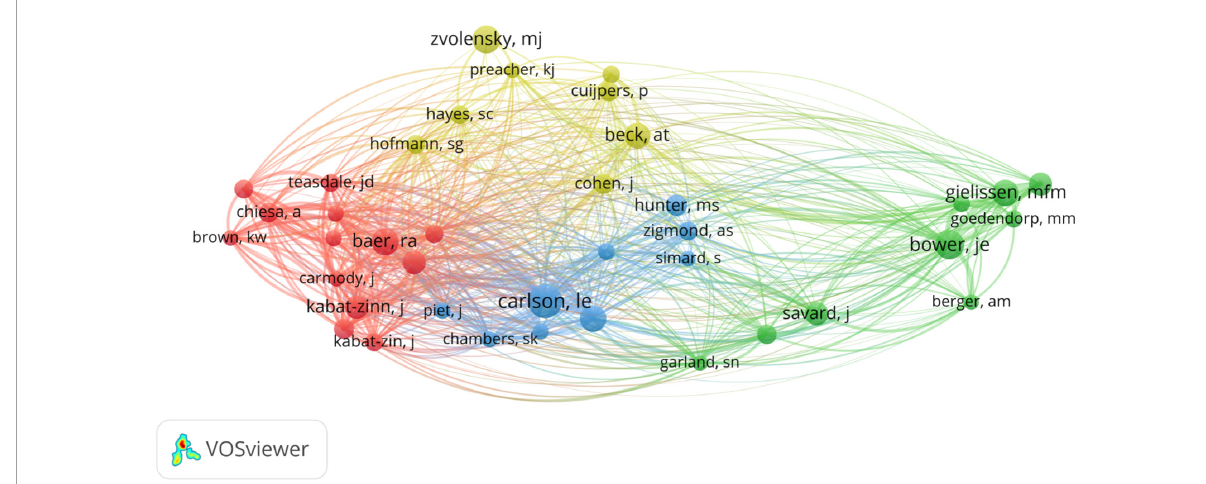
FIGURE8 Co-citations network diagram between authors with more than 50 citations.